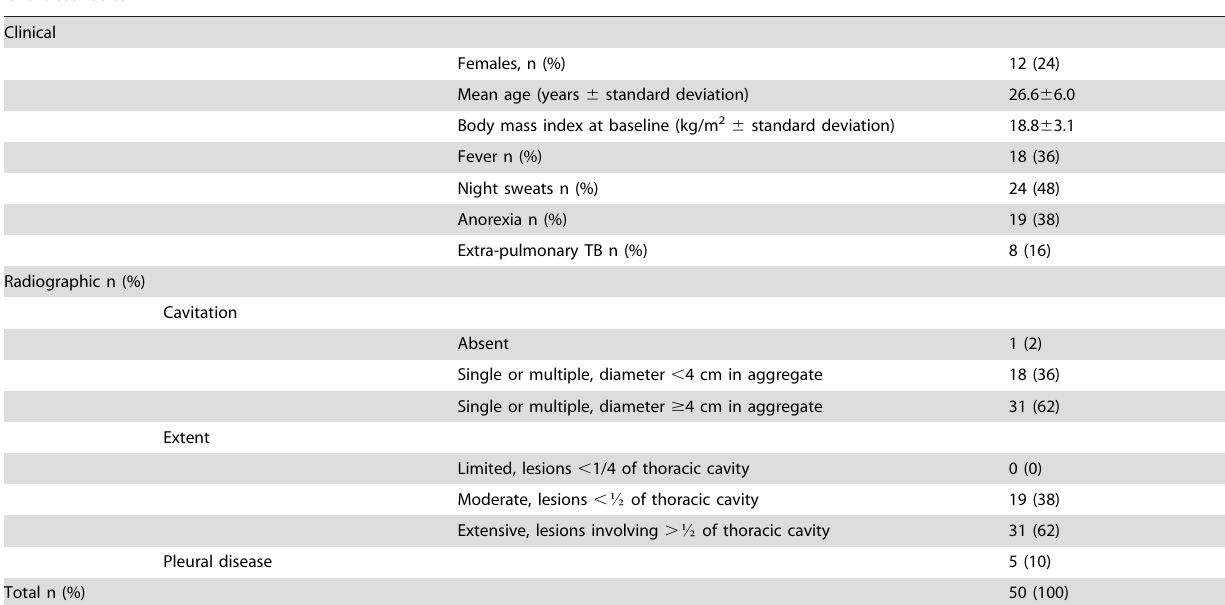
Table 1. Baseline Characteristics.